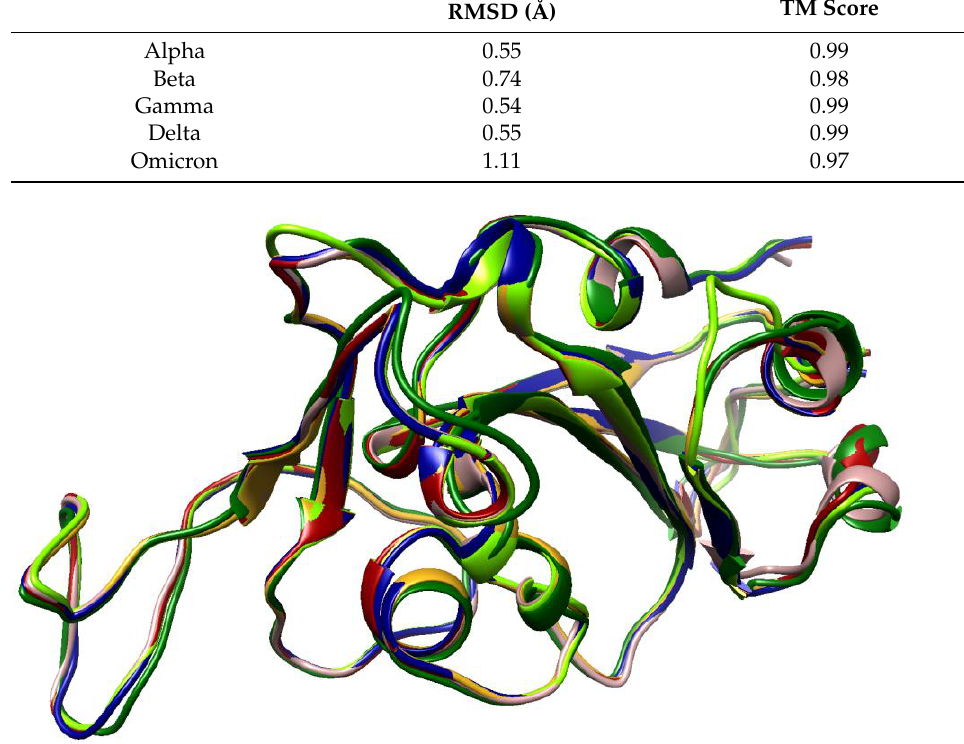
Figure 3. VOC RBD overlapping. Typical view of the orientation of the RBD of each VOC when it is coupled with the receptor. Rosy, brown—reference original structure, dark red—Alpha, dark green—Beta, golden rod—Gamma, navy blue—Delta, and chartreuse—Omicron.